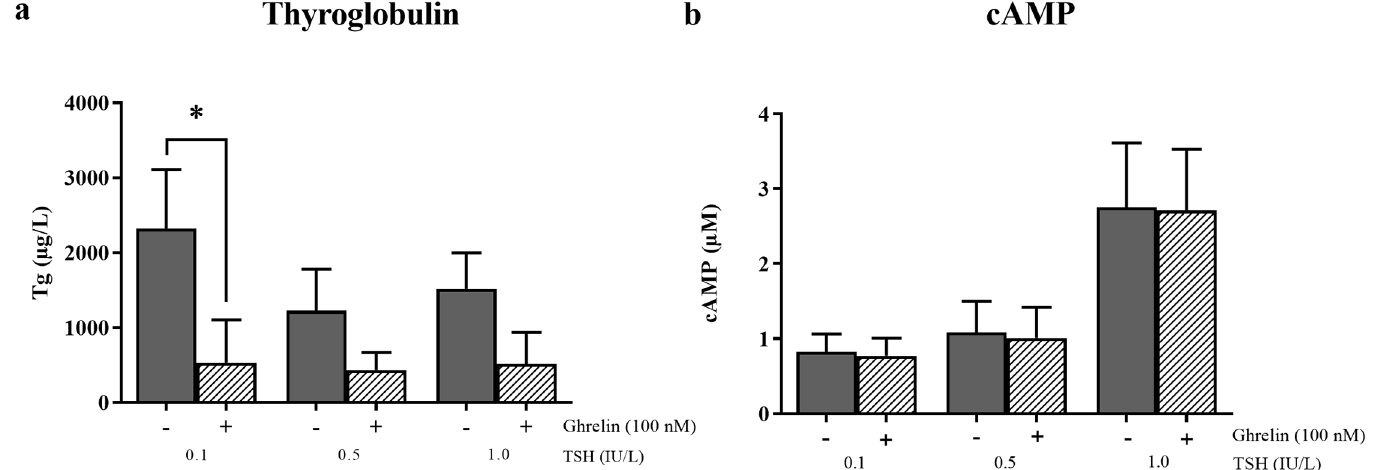
Fig 2. The influence of ghrelin on the thyroid-stimulating hormone (TSH)-induced increasein thyroglobulin (Tg) and cAMP production. The influenceof ghrelinon the TSH-induced increasein Tg and cAMP production at three different concentrations of TSH (0.1 IU/L, 0.5 IU/L and 1 IU/L). The basal levels, i.e. the values in the absenceof TSH, were subtracted, before the groups were compared. Grey = vehicle, pattern = ghrelin(100 nM). Means (+SEM). * P < 0.05 comparedto the control (vehicle). A) Ghrelininhibitedthe TSH-induced increasein Tg production measured by enzyme-linked immunosorbent assay (ELISA) in primary cultures of humanthyroid cells for the TSH concentration of 0.1 IU/L. n = 8 (0.1 IU/L) and n = 6 (0.5 and 1 IU/L) in triplets. Two patient samples were excludeddue to lack of basal TSH-induced Tg production. B) No influenceof ghrelinon the TSH-induced increasein cAMP production at three different concentrations of TSH (0.1 IU/L, 0.5 IU/L and 1 IU/L) measured by a competitiveprotein bindingmethod in primary cultures of human thyroid cells. n = 8 (0.1 IU/L and 1 IU/L) and n = 6 (0.5 IU/L) in triplets.